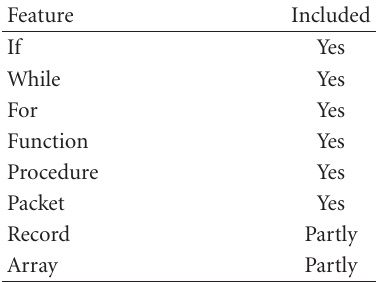
Table 1: V2SC features.